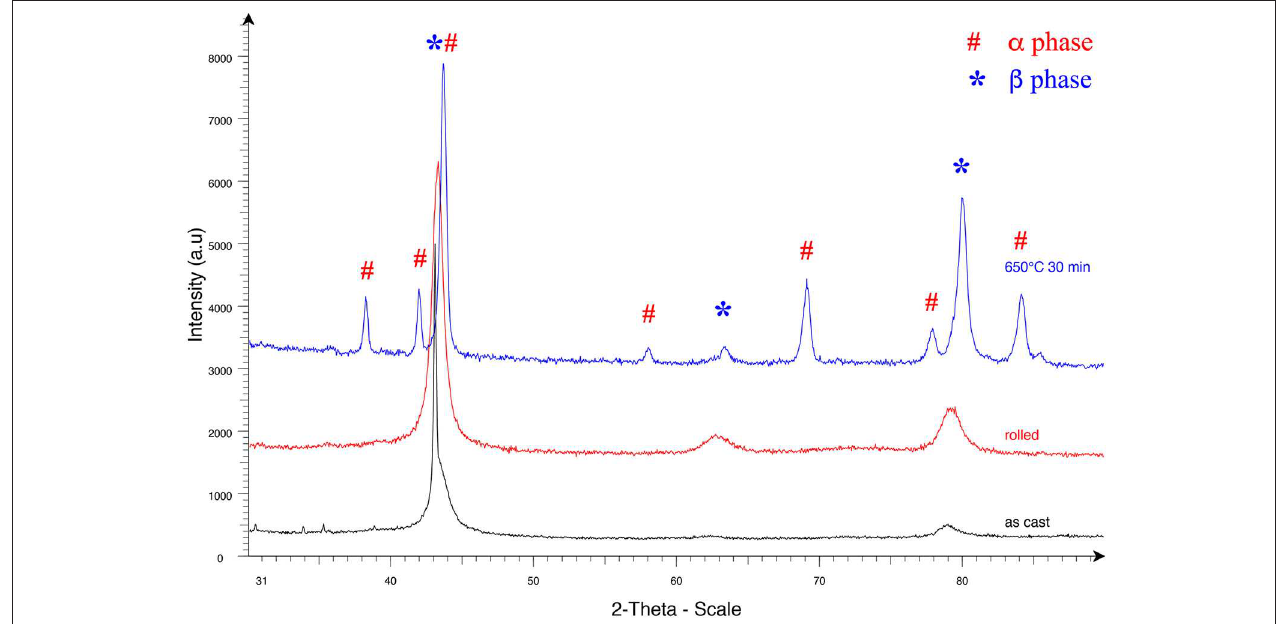
FIGURE 1 | X-ray diffraction (XRD) pattern of Ti35-6.5-6.5 sample, as cast, after 90% cold rolling and after 30min at 650 ◦ C. The bcc reflections are indicated by an asterisk and hcp ones by a hash.